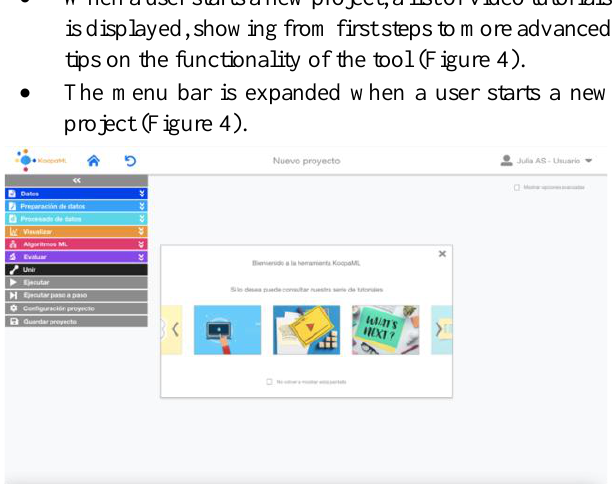
Figure 4. Second digital prototype of the project editor when a user starts a new project.